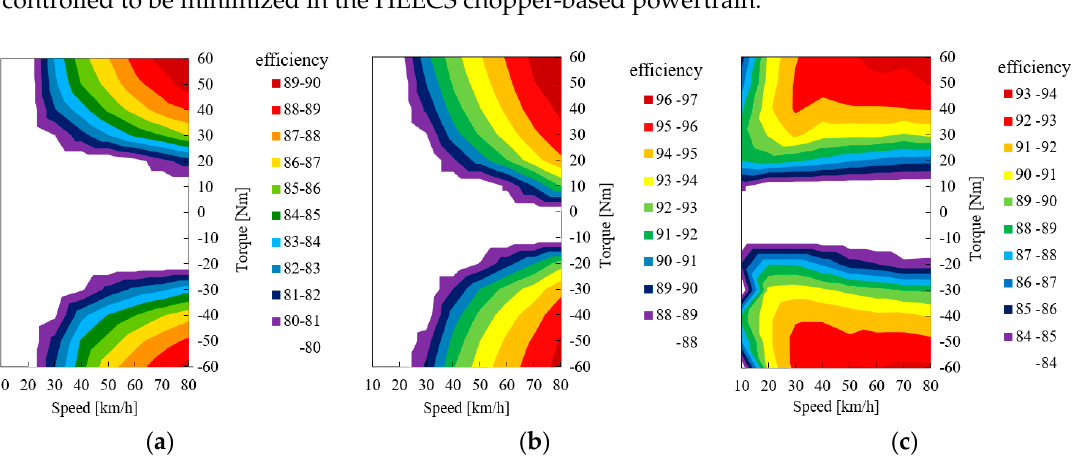
Figure 4. E ffi ciency maps of non-chopper powertrain: ( a ) Total e ffi ciency; ( b ) inverter e ffi ciency; ( c ) motor e ffi